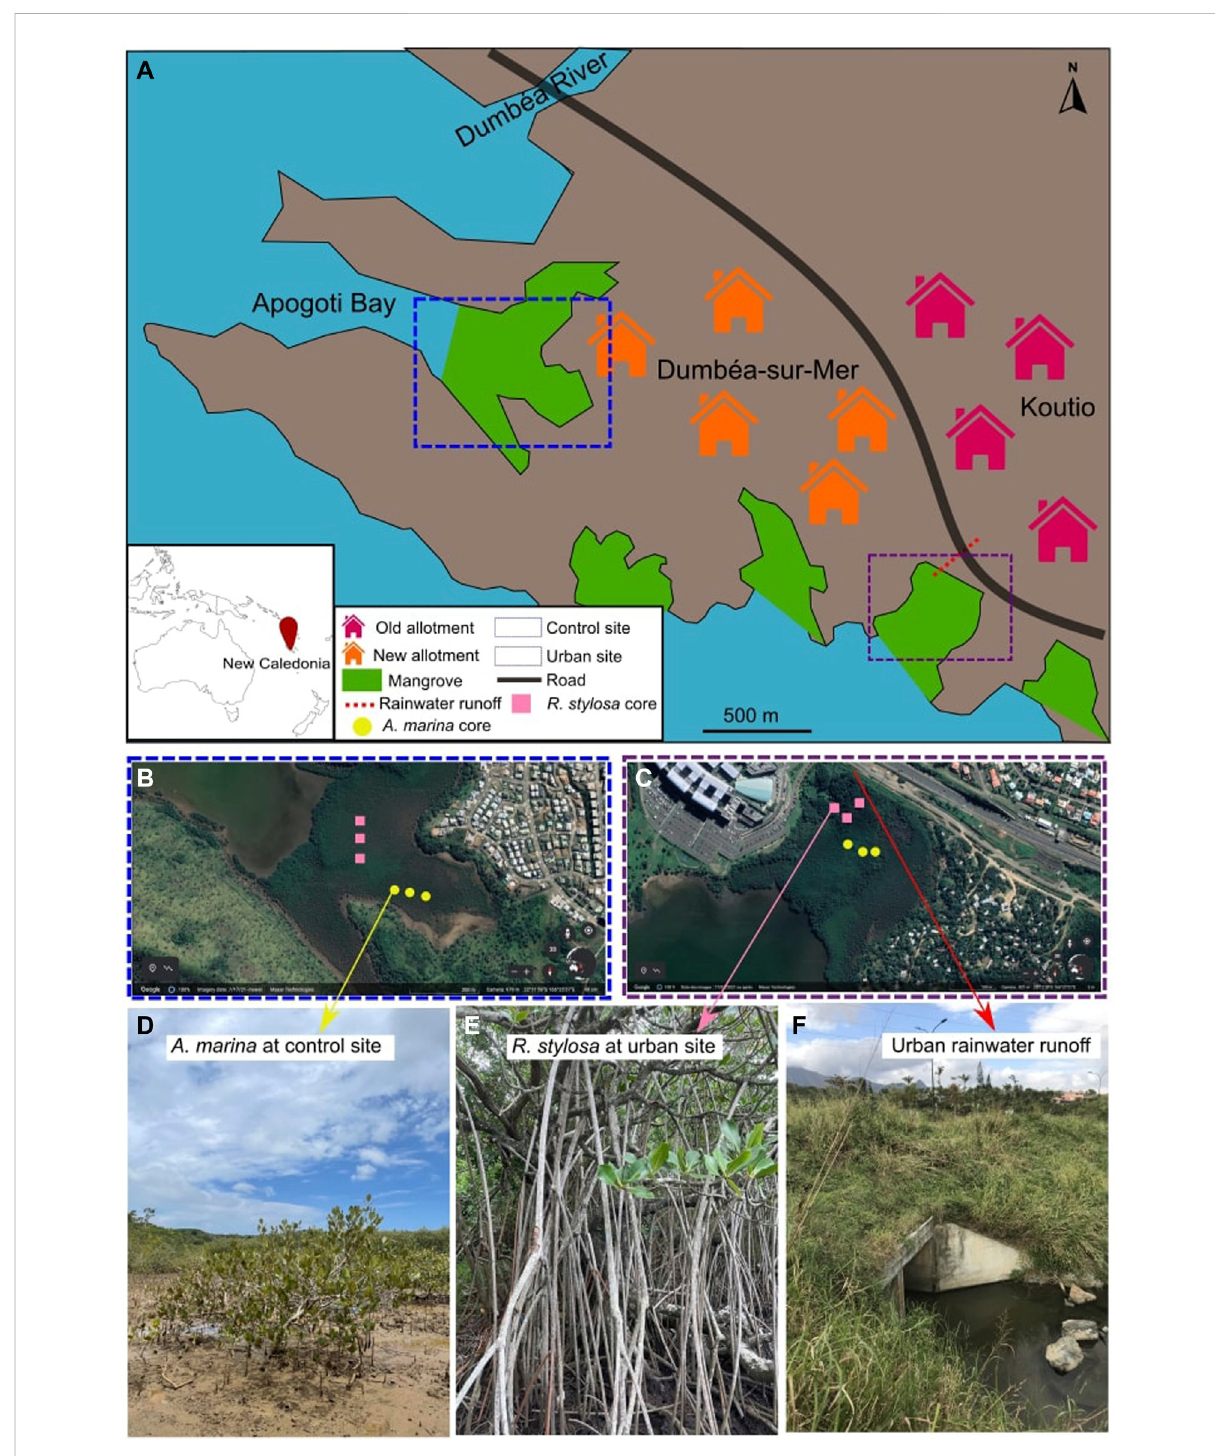
FIGURE 1 Map ofthe twostudied mangrovesites (A) with triplicate soilcorestakenunder A.marina and R. stylosa atthecontrol site (B) and urban site (C) , and pictures of A. marina at the control site (D) , R. stylosa at the urban site (E) , and the entrance of the urban rainwater in the urban site (F) .